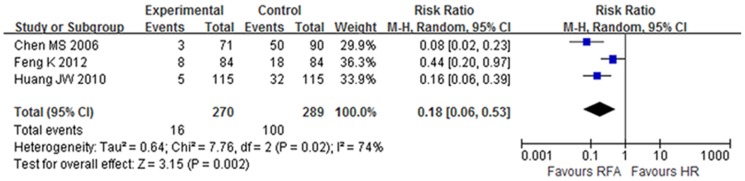
Complication rate of RCTs.